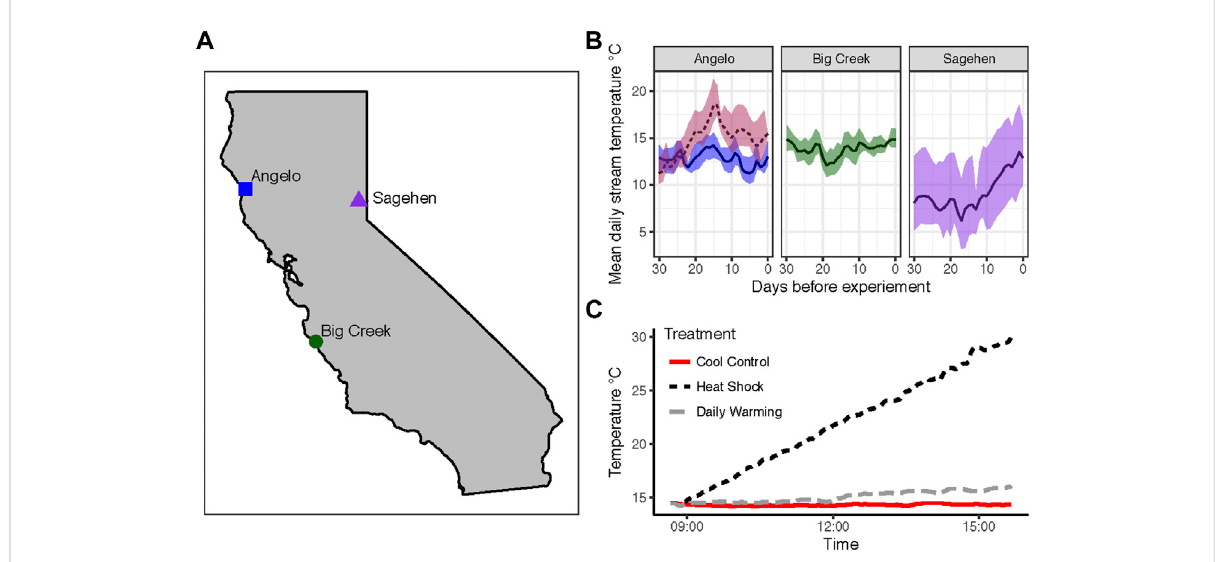
FIGURE 1 Thermal histories and experimental exposures of larval Dicosmoecus gilvipes caddis fl ies (A) Three California populations used in this study and (B) streamtemperaturesateachofthesesitesinthe30 daysbeforetheexperiment.Thedatarepresentthefollowingdatesfromeachsite:Angelo(4/ 29/13 – 5/29/13 and 5/24/13 – 6/22/13) in blue and pink, respectively, Big Creek (5/10/13-6/9/13) in green, and Sagehen (5/12/13 – 6/11/13) in violet. Thesolidlinerepresentsthemeandailystreamtemperature.Theshadedareaaroundthelineindicatesthedailytemperaturerange (C) Example of experimental temperature treatments from Big Creek (6/9/13). Colors and line types represent the warming treatment.